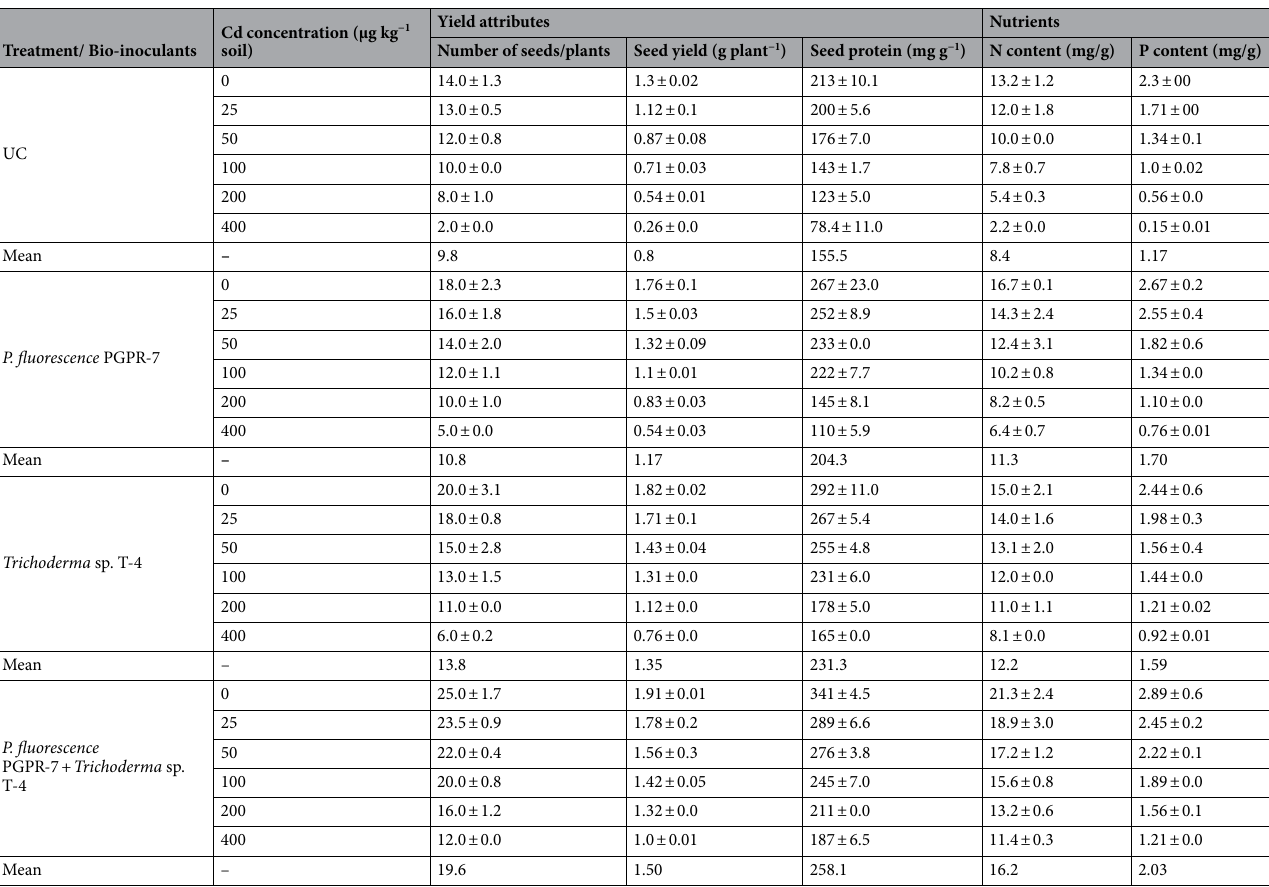
Table 4. Single and combined inoculation impact of metal tolerant Pseudomonas fluorescence PGPR-7 and Trichoderma sp. T-4 on yield attributes and nutritional content of chickpea raised in Cd-treated soils. Each value is a mean of three replicates where each replicate constituted three plants/pot. Mean values are significantly at P ≤ 0.05. Means followed by similar alphabets are different from each other according to DMRT test. Here, Cd = cadmium, µg/kg = micrograms per kilograms, N = nitrogen, P =